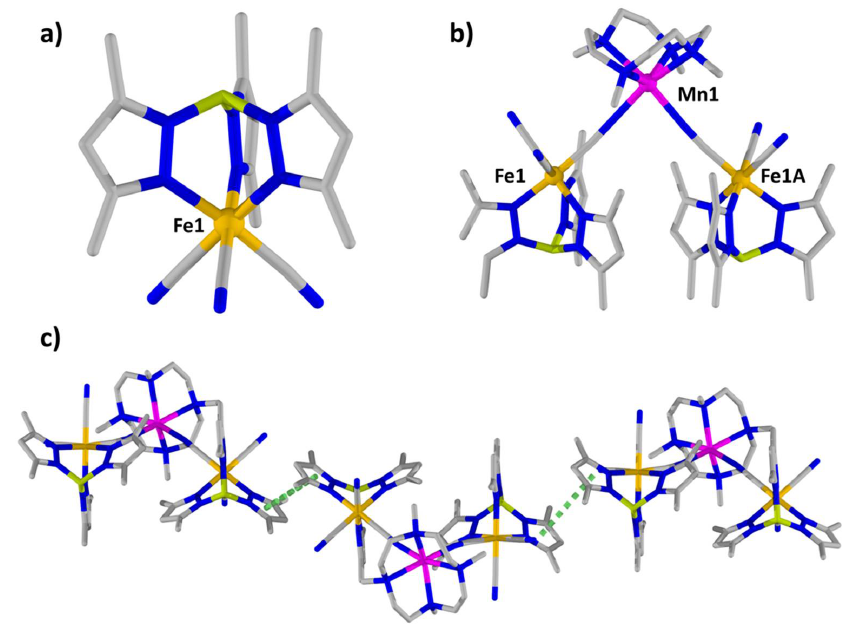
Figure 2. ( a ) View of the [Fe III (pzTp)(CN) 3 ] − anion in 1 ; ( b ) the molecular unit in 1 ; and ( c ) the π-π interaction in 1 .